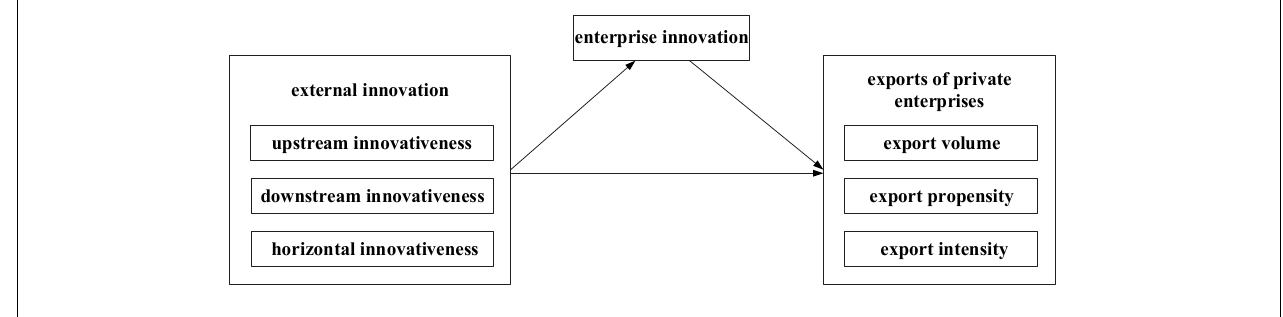
FIGURE 1 | Conceptual